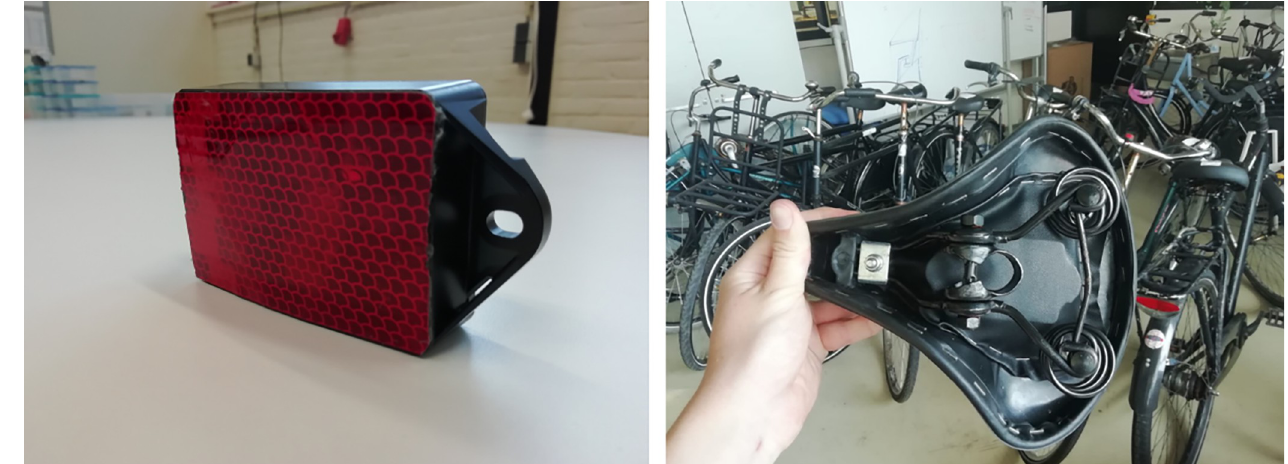
Fig 5. left: Placement of tracker as reflector, right: Placement of tracker underneath the seat.